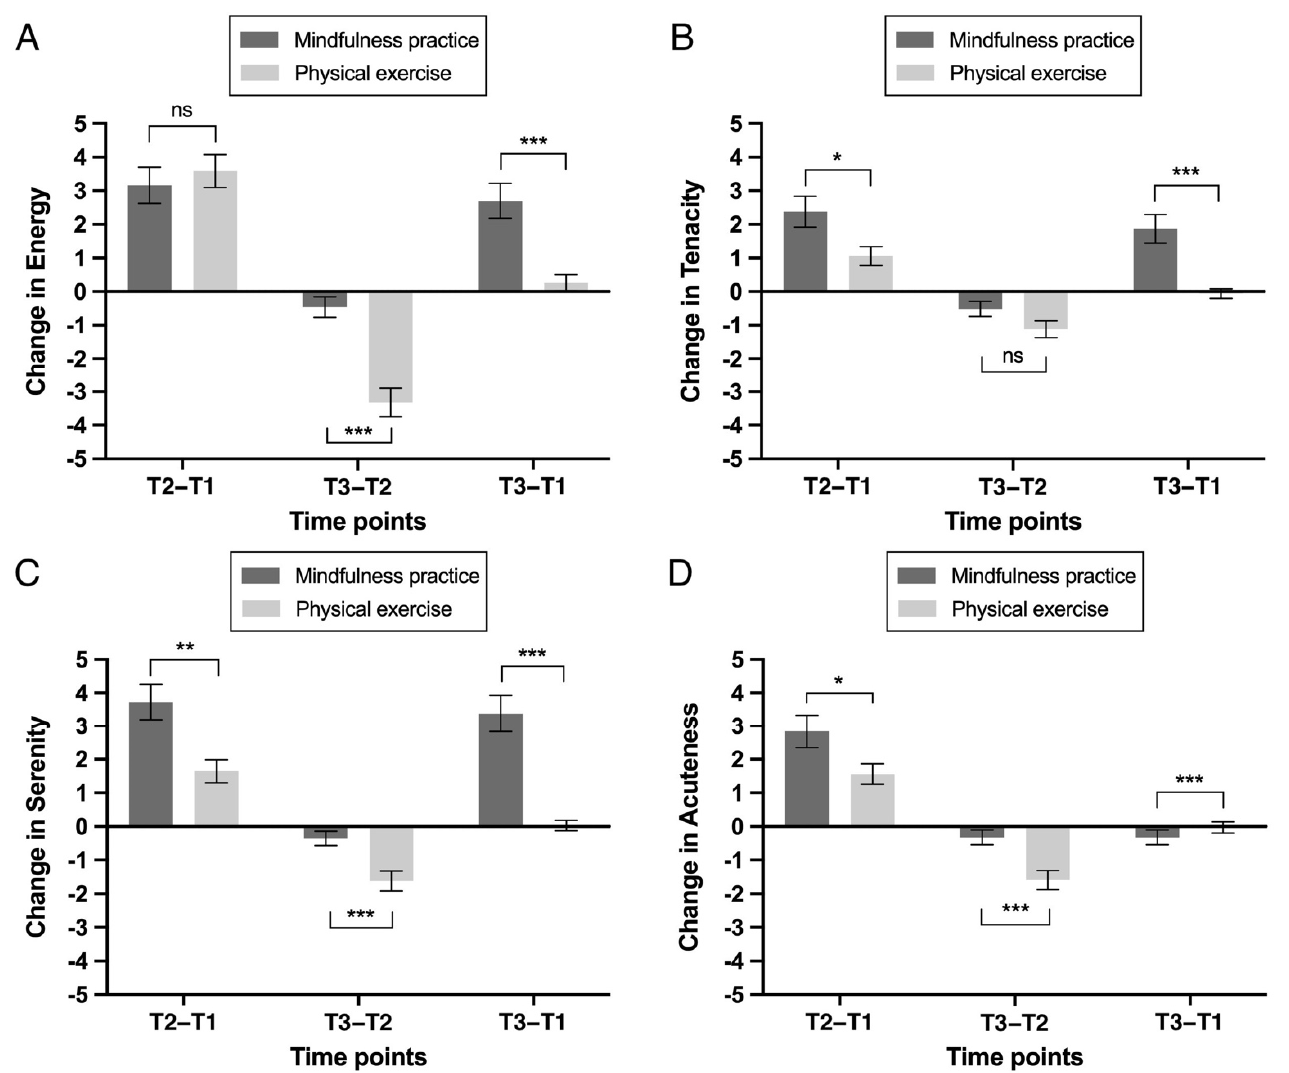
Figure 3. Changes in factors of vitality, i.e., ( A ) energy, ( B ) tenacity, ( C ) serenity, and ( D ) acuteness, across different time points (from T1 to T2, from T2 to T3, and from T1 to T3) in the mindfulness practice group and the physical exercise group. *** p < 0.001; ** p < 0.01; * p < 0.05; ns, not significant.